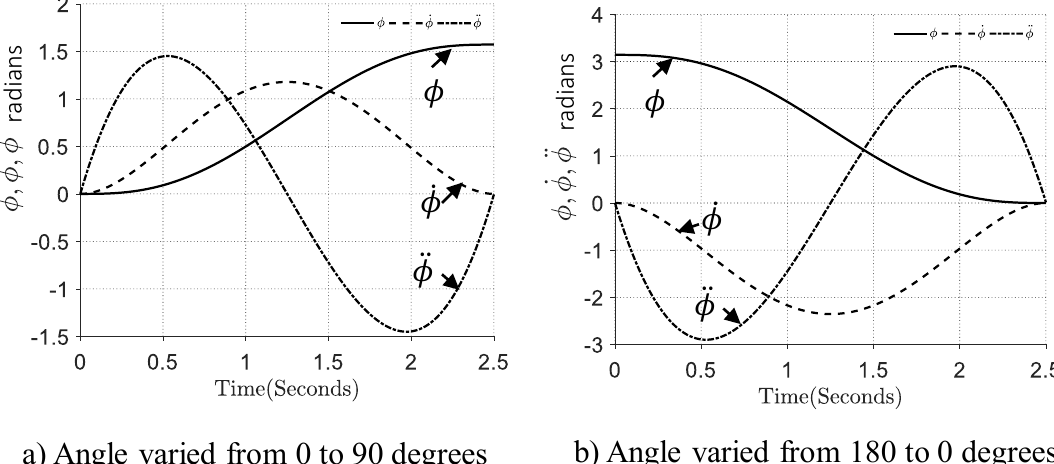
Figure 7. Quintic trajectory for inverse dynamics during reconfiguration using hinge joints.